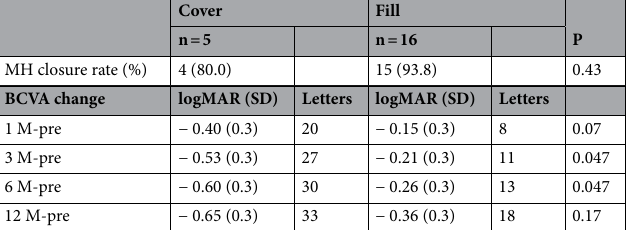
Table 3. Postoperative changes in BCVA and the MH closure rate of the cover group and the fill group. Wilcoxon’s rank-sum test, Fisher’s exact test. BCVA best-corrected visual acuity, MH macular hole, logMAR logarithm of minimum angle of resolution, pre pre-operative, SD standard deviation.